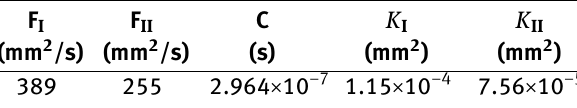
Table 4: 2D permeability results for 200 gsm woven fabric F I